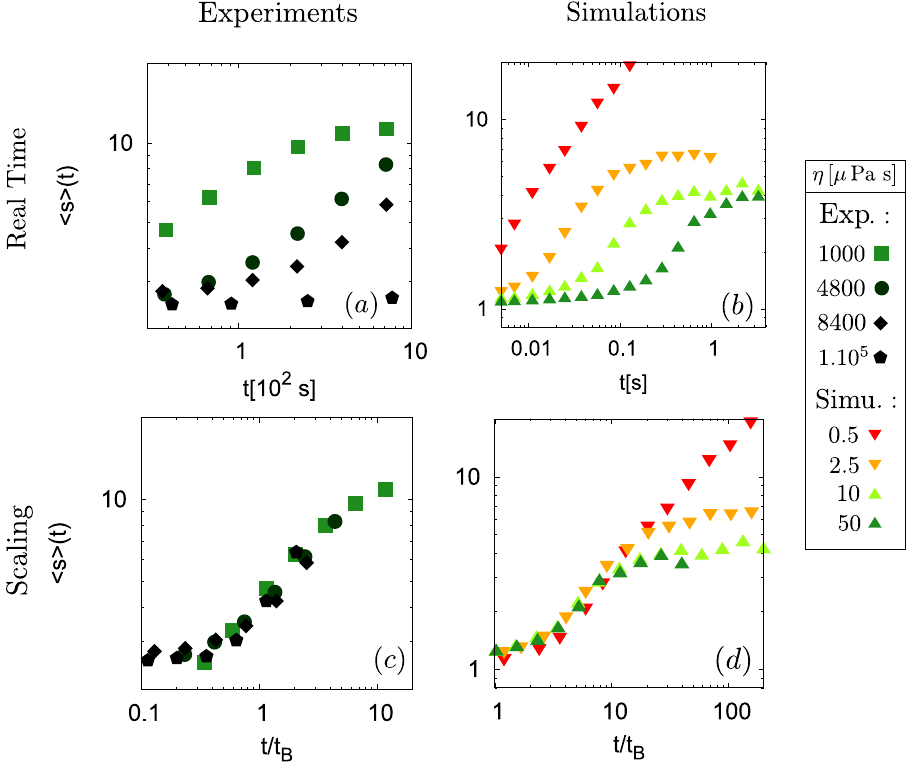
Figure 2. Log-log plots of the evolution of the mean size of the chains 〈 s 〉 during experiments (( a ) and ( c )) and simulations (( b ) and ( d )). The mean chains length is expressed in mean diameter of particles. After a transient behaviour whose duration depends on the viscosity, a power law growth is obtained with an exponent close to 0.5. In ( a ) and ( b ), a clear trend can be seen on that graph: the higher the viscosity, the slower the growth. In ( c ) and ( d ), the mean size of the chains is plotted as a function of the parameter t / t B , where the characteristic time is defined in equation (3). All experimental curves then collapse. In simulations, if the magnetic field B = 12 G, curves collapse only for η > η c , with η µ µ ∈ . ]2 5 Pa s; 5 Pa s[ . Colours and points shapes correspondence are c described in the box on the right